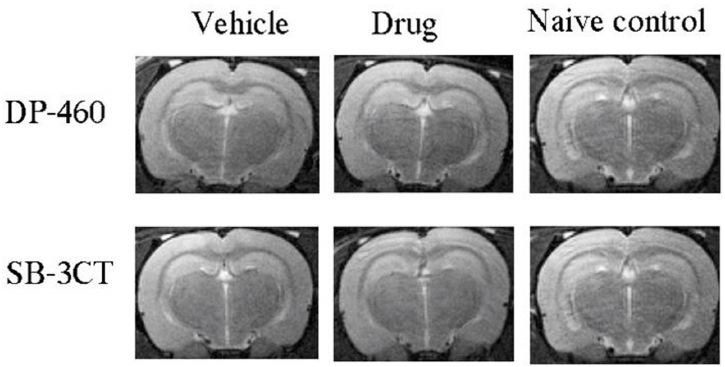
Fig 2. Brains are unchanged with DP-460 and SB-3CT treatments. Representative T2-MRI images were obtained at 16 weeks of life for DP-460 and 20 weeks of life for SB-3CT. No differences were found among treatment and control groups (n =